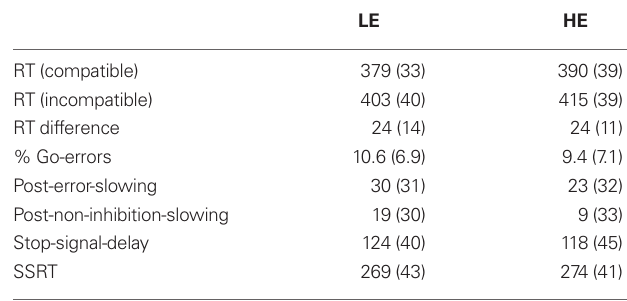
Table 2 |Behavioral results of modified Flanker task (Study